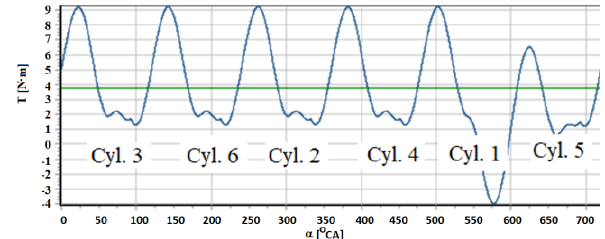
Fig. 2. The waveform of the torque of the engine crankshaft as a function of the rotation angle of the crankshaft (cylinder no. 1 is supplied with an amount of fuel reduced by 80%)